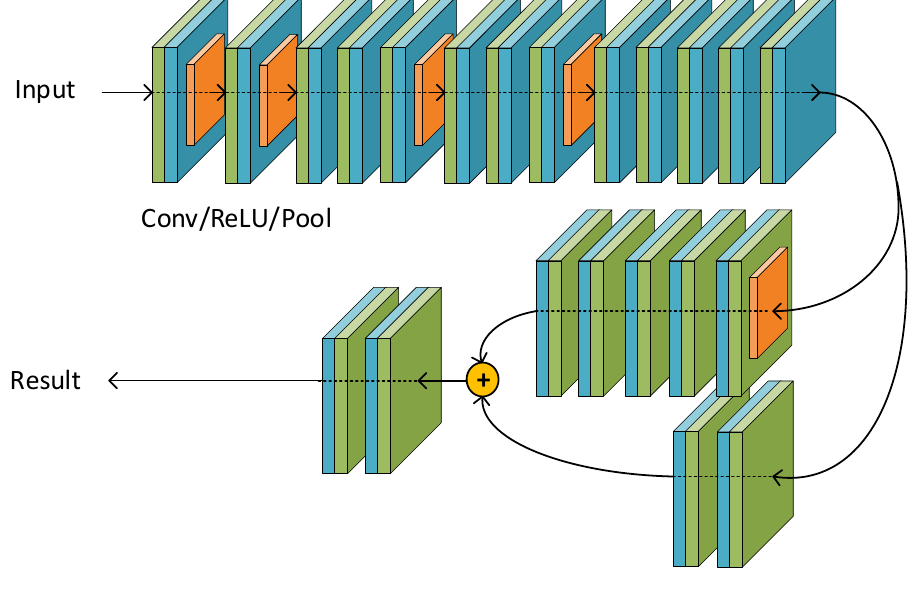
Figure 3. Combined Model structure of YOLOv2 as executed as a single